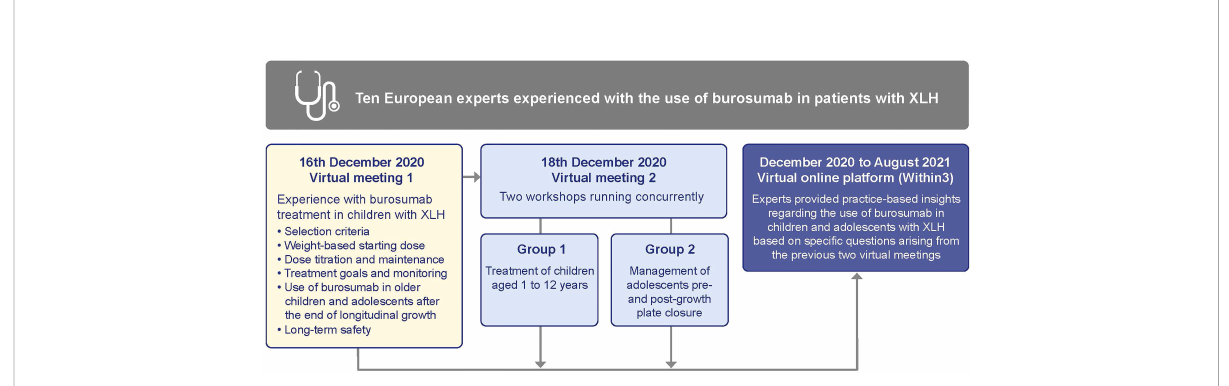
FIGURE 1 Format of the Expert Practice Exchange meetings. XLH, X-linked hypophosphatemia.